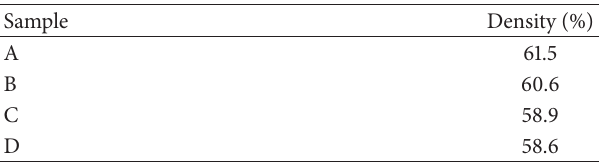
Figure 1: Effect of dispersant concentration on the viscosity of AZO slurries with different particle sizes of 45, 120, 230, and 510 nm. Table 1: Relative densities of AZO green